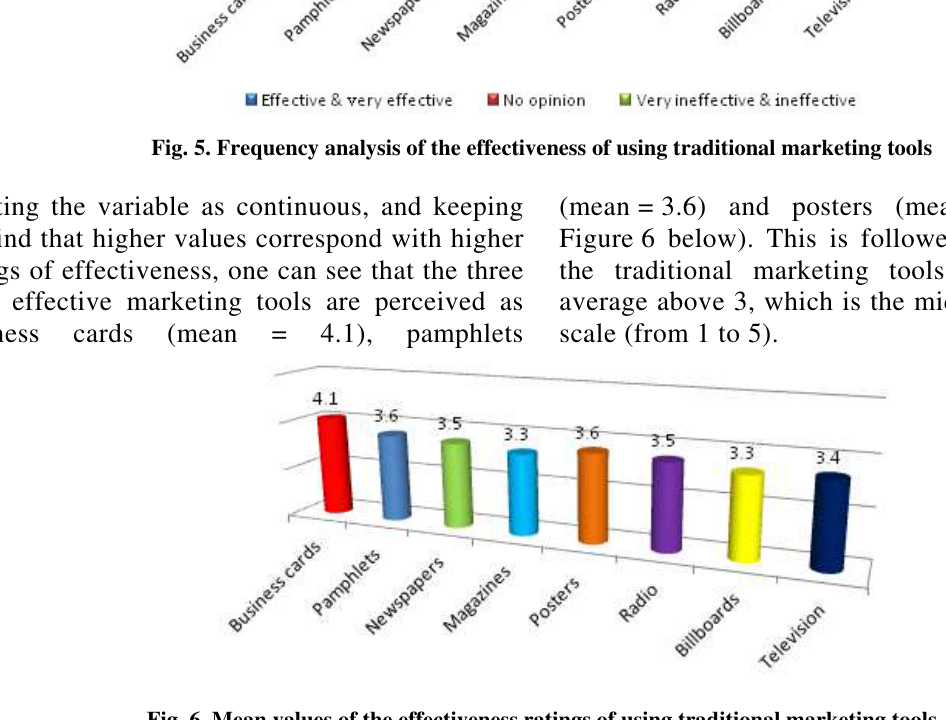
Fig. 6. Mean values of the effectiveness ratings of using traditional marketing